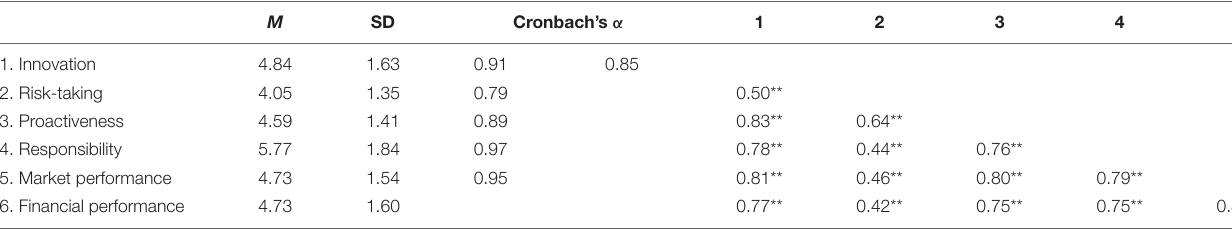
TABLE 2 | Descriptive statistics and variable reliability and correlation.